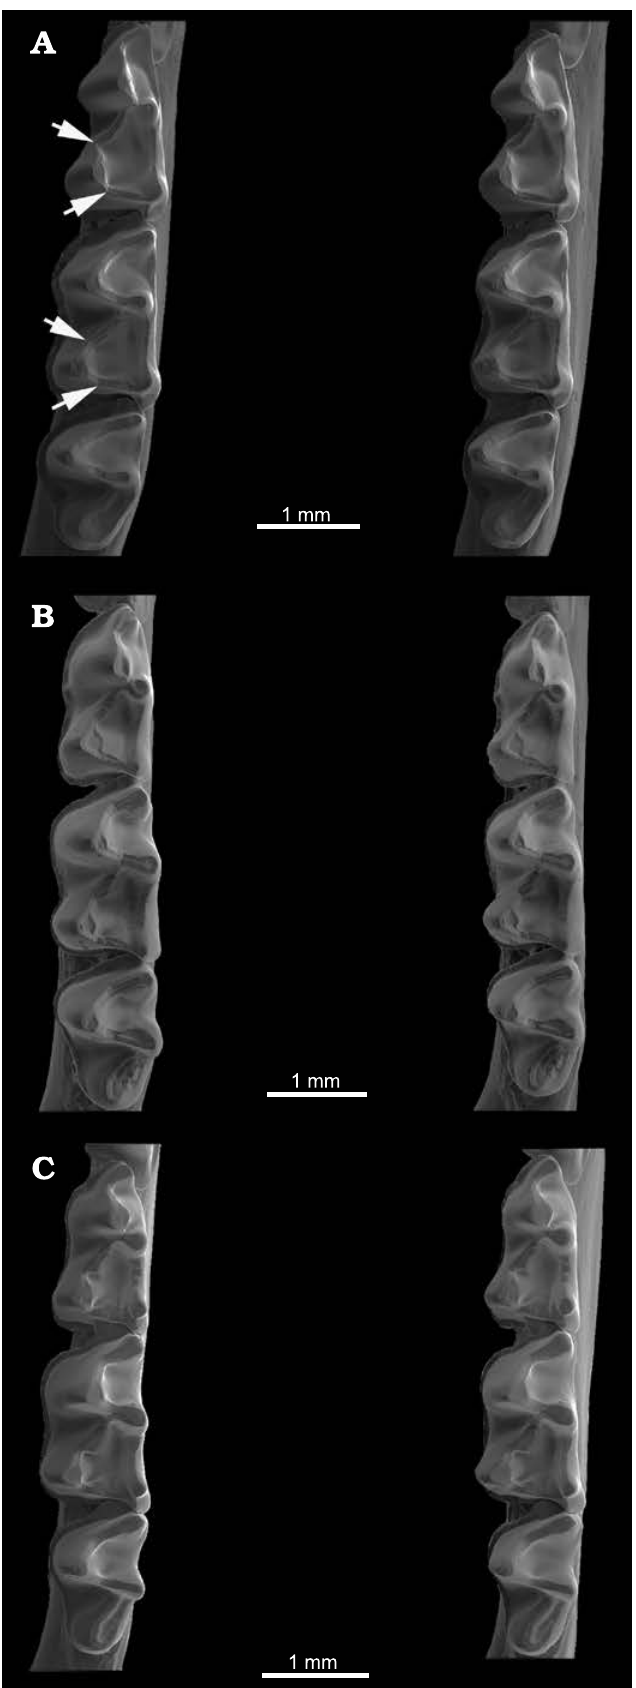
Fig. 6. Lower molars of Recent phyllostomid bats in occlusal view, show- ing carnassiform notches in the talonid crests and accompanying accessory troughs in the m1–m2 (indicated by arrows). A . Lampronycteris brachyotis (Dobson, 1878a) (USNM 306546) from Panama. B . Micronycteris hirsuta (Peters, 1869) (AMNH 139441) from Costa Rica. C . Micro nycteris mega­ lotis (Gray, 1842) (OMNH 6194). All